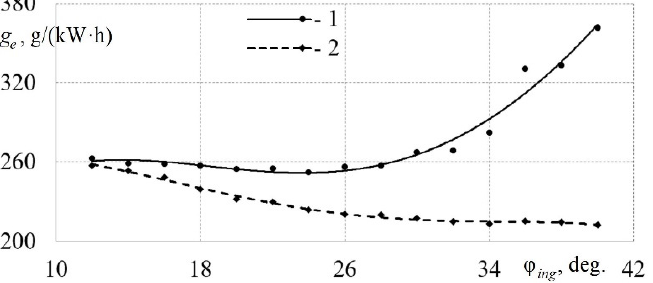
Figure 12. Dependence of the specific effective fuel consumption g e on the fuel injection advance angle φ inj in different operating modes: 1—position No. 1 (idle); 2—rated power. angle ϕ inj in different operating modes: 1—position No. 1 (idle); 2—rated power.